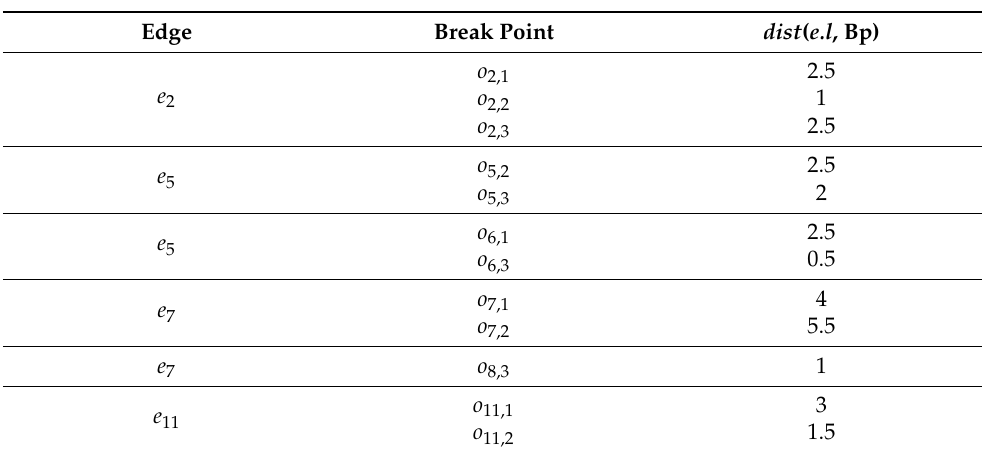
Table A3. List of break points.